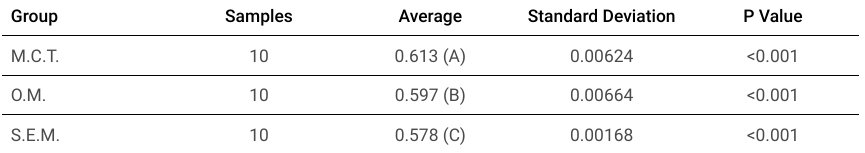
Table 1. Dental implants vertex to vertex average and standard deviation evaluation. Letters between parentheses demonstrate statistical differences. Group